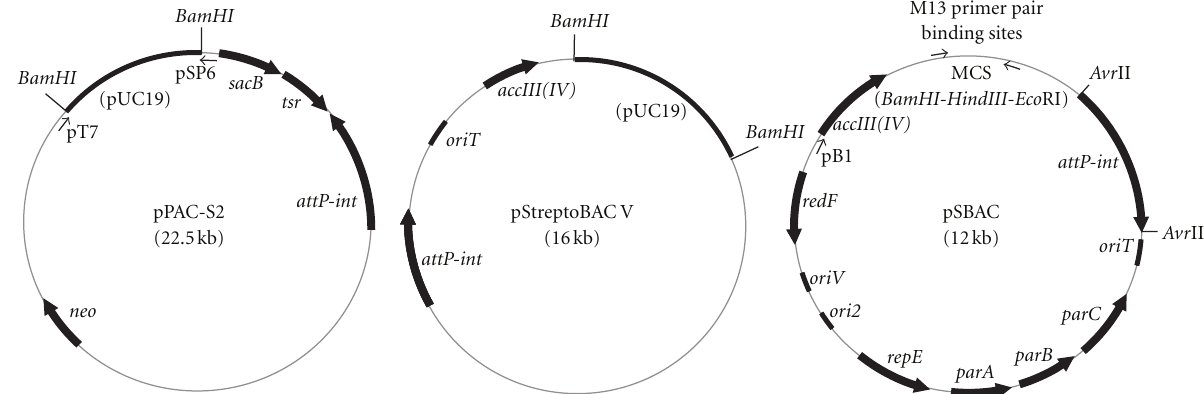
Figure 3: Comparison between physical maps of E. coli - Streptomyces artificial chromosomes. The vector pPAC-S2 derives from PAC, while pSTREPTOBAC V and pSBAC from BAC. The main features of the vectors are depicted: the resistance genes ( neo, accIII(IV), tsr conferring resistance to kanamycin, apramycin, thiostrepton), attP-int cassettes for the site-specific integration in Streptomyces, restriction sites ( Bam HI, Hind III , Eco RI), sacB (conferring sensitivity to sucrose when expressed), oriT and oriV , devoted to intergeneric conjugation and inducible high copy number of the vector,